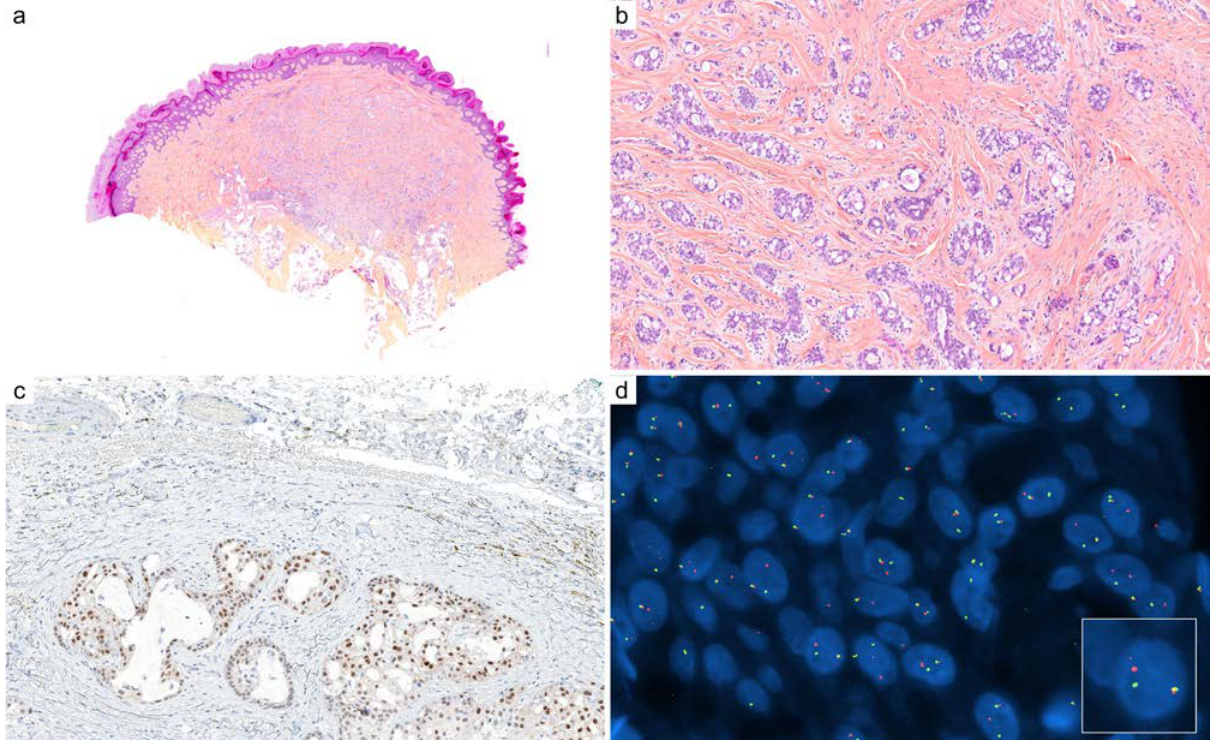
Figure 7. Cutaneous secretory carcinoma: ( a ) circumscribed intradermal neoplastic proliferation (×10); ( b ) intracytoplasmic secretory vacuoles and extracellular bubbly eosinophilic secretions (×100); ( c ) nuclear staining with panTRK immunohistochemistry is highly suggestive of ETV6::NTRK3 fusion (×200); ( d ) fluorescence in situ hybridization (FISH, break-apart) demonstrates clonal and balanced rearrangement of NTRK3 gene (x1000).